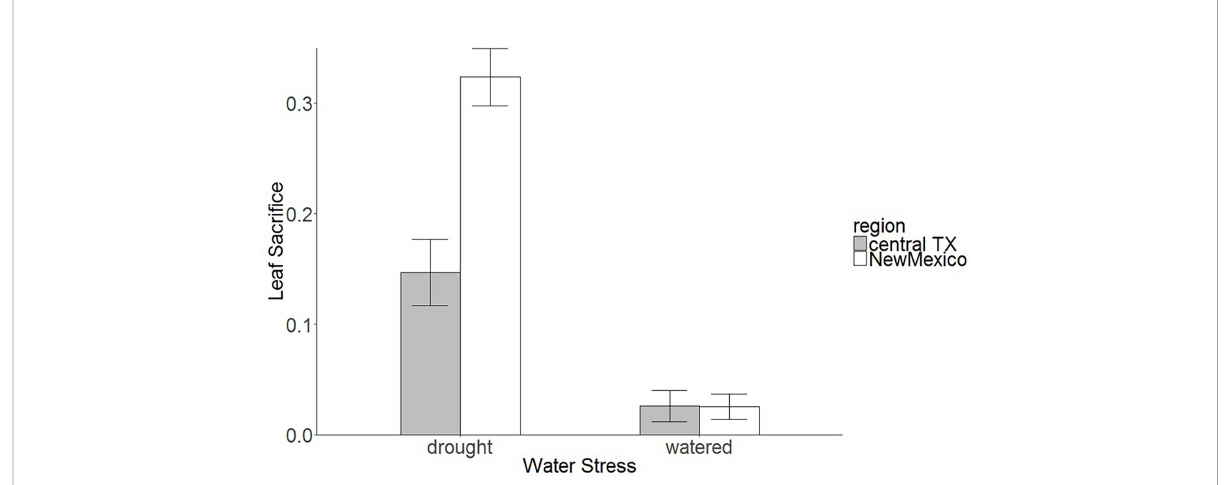
FIGURE 2 Leaf loss (biomass loss by senesced leaves from total biomass, senesced leaf biomass: total biomass) in different populations of saltcedar from the Central Texas and the desert region of New Mexico. See Figure 1 for sampling sites. Histograms represent mean proportion of leaves senesced from the total biomass, and error bars represent 95% con fi dence